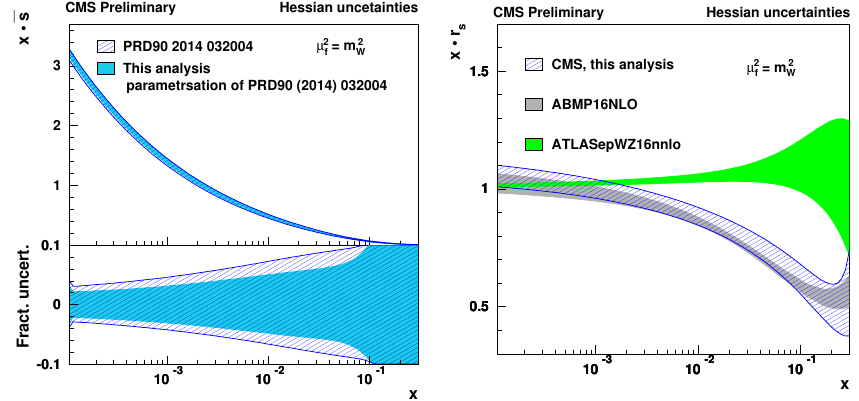
. The result of the current analysis (filled W compared to ABMP16nlo (dark shaded band) W